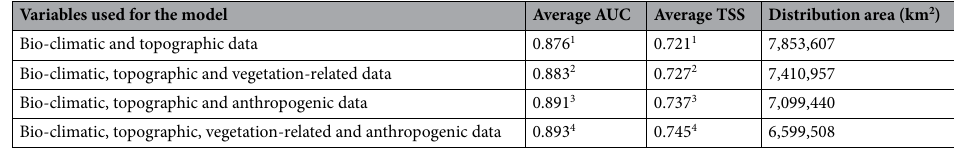
Table 2. Performance of models to predict suitable habitat for Egyptian vultures, based on AUC (Area Under the receiver operating characteristic Curve) and TSS (True Skills Statistic). The estimated total suitable distribution area in km 2 for each model formulation is also given. Higher number of superscript denotes the significantly higher accuracies of the model at p < 0.05 relative to model formulations with lower numbers.